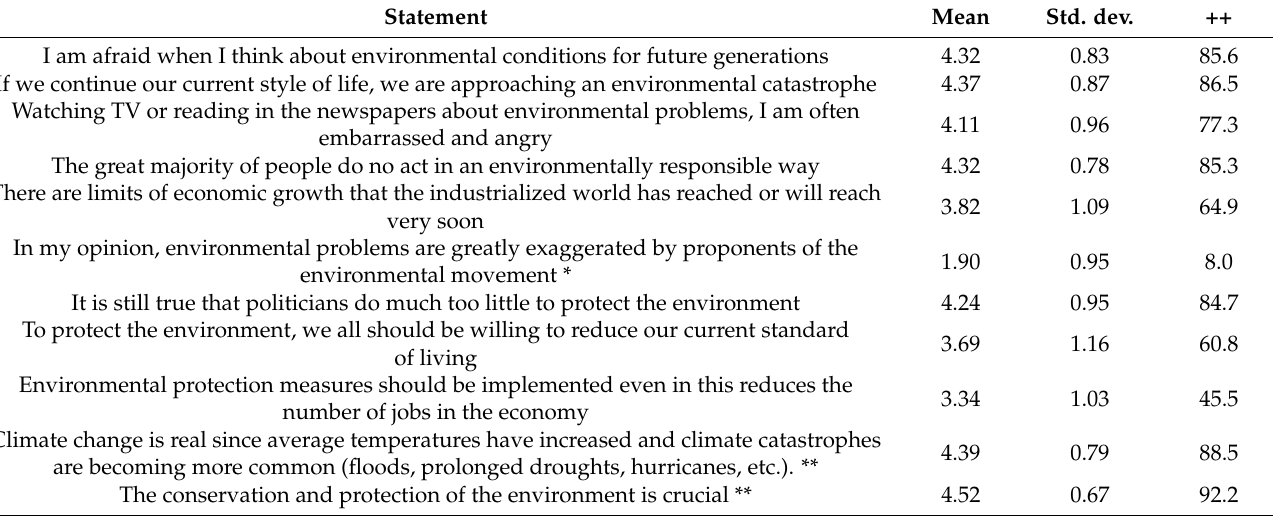
Table 1. Statements for measuring environmental concern and their descriptive statistics following Diekmann and Preisendörfer